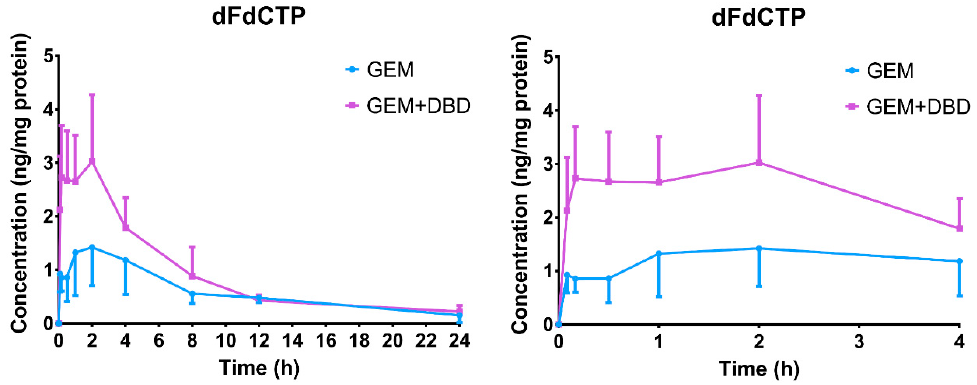
Figure 3. Concentration-time profiles of dFdCTP in rats peripheral blood mononuclear cells (PBMC) after administration of GEM and DBD (with partially enlarged view on the right). Data were expressed as mean ± SD ( n = 10). Rats in the GEM group received a tail vein bolus intravenous administration of 50 mg / kg gemcitabine. In the GEM + DBD group, DBD was co-administered at the dose of 3.6 g / kg by intra gavage administration, whereas the GEM group was treated with saline. Table 2. Pharmacokinetic parameters of dFdCTP in rat PBMC after single administration of GEM and GEM + DBD. Data are shown as mean ± SD ( n = 10), *** p < 0.001 compared with the GEM group.